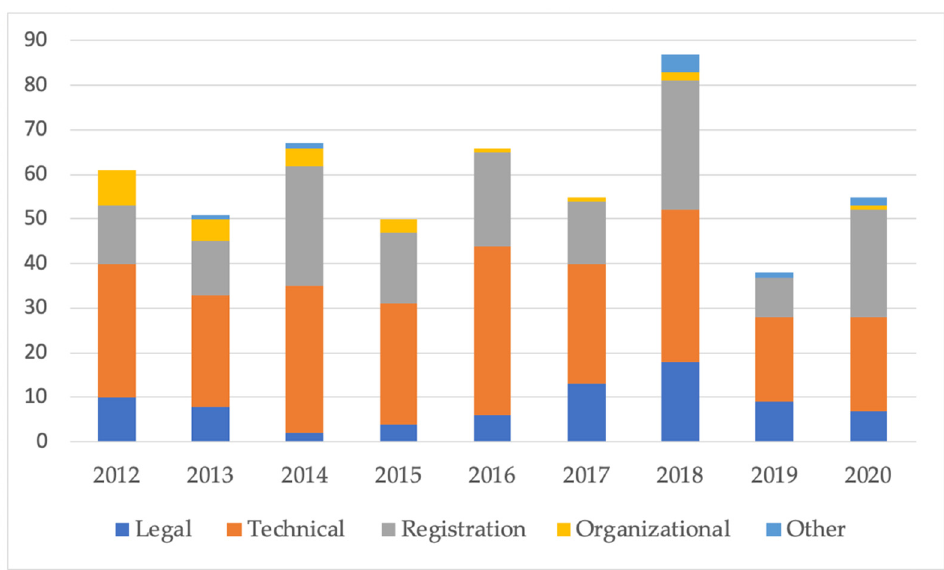
Figure 4. Distribution of publications in the main categories 2012–2020.